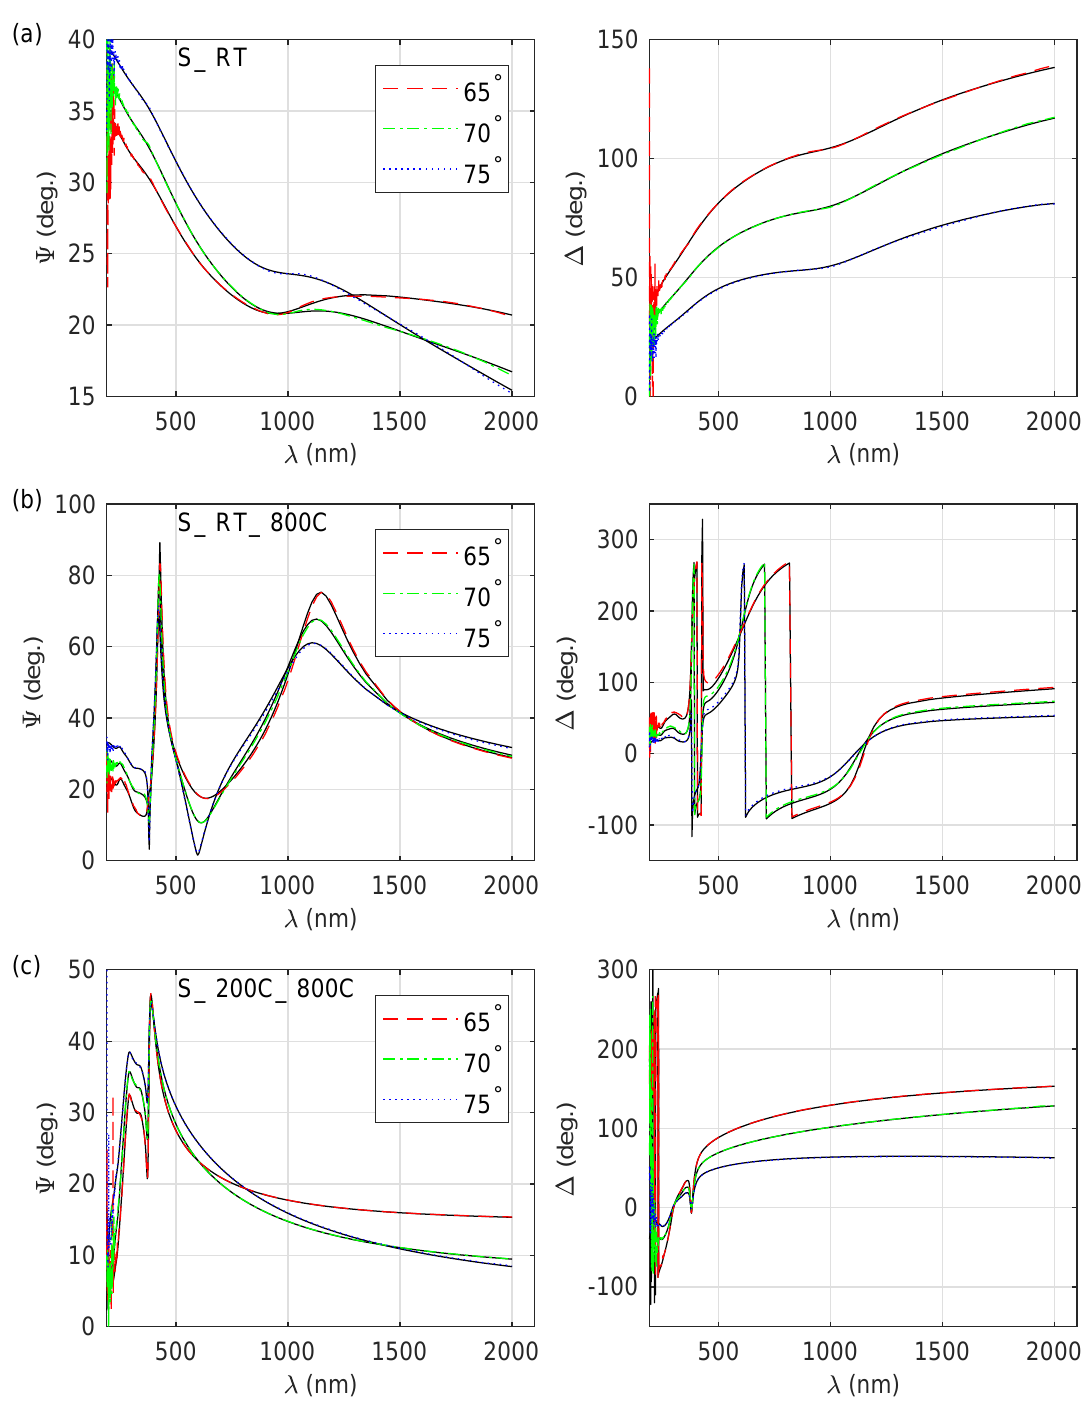
Figure 1. Experimental and calculated ellipsometric azimuths Ψ and ∆ for ( a ) S_ RT ( χ 2 = 2.233), ( b ) S_ RT_ 800 ( χ 2 = 2.242) and ( c ) S_ 200C_ 800C ( χ 2 = 2.57)